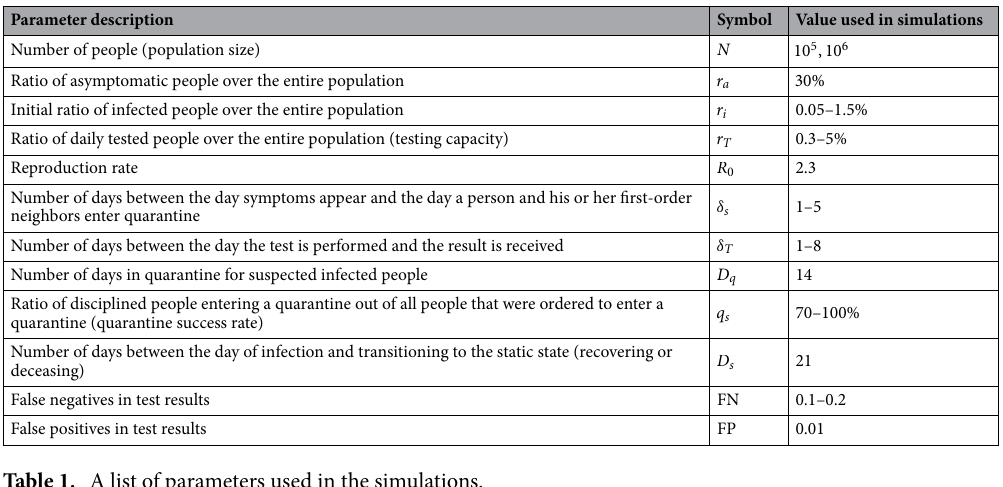
Table 1. A list of parameters used in the